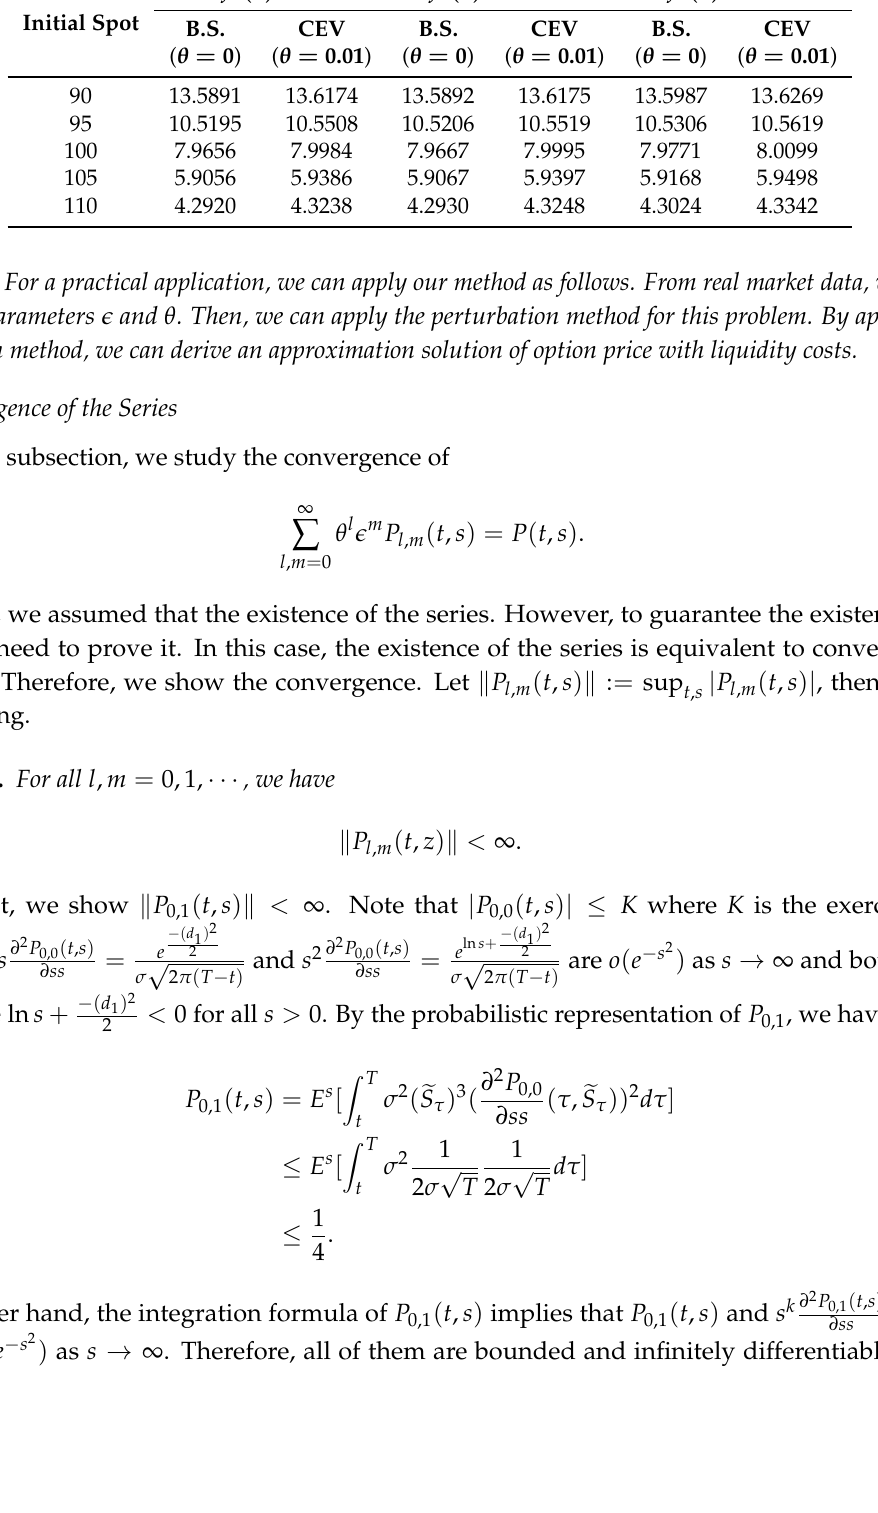
Table 1. Put option price with liquidity costs ( K = 100, T − t = 1(year), r = 0, σ = 0.2). f (cid:48) ( 0 ) = Initial Spot